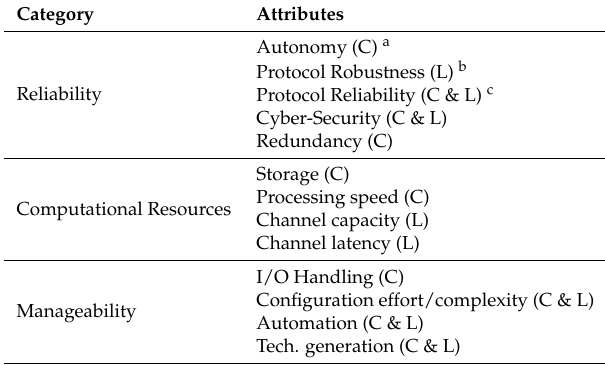
Table 3. List of categories and their attributes with component/link